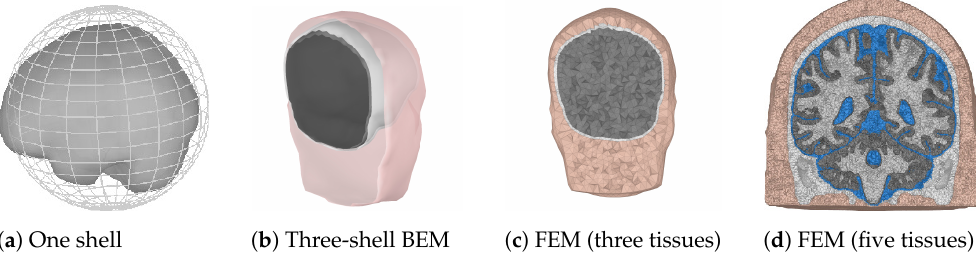
Figure 2. Examples of three different forward models. Colors are used to indicate different tissue types. ( a ) A one sphere brain representation, with the brain surface indicated for completeness. ( b ) Pink represents the skin shell, white the outer skull shell, and black the inner skull shell. ( c , d ) Pink and white are used for the skin and the skull, respectively. Gray is used for the whole brain in ( c ). Gray and white are used for the gray and white matter, and blue is used for the CSF in ( d ).